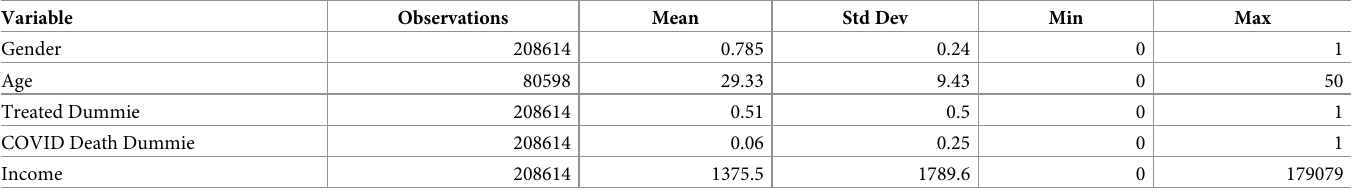
Table 2. Summary